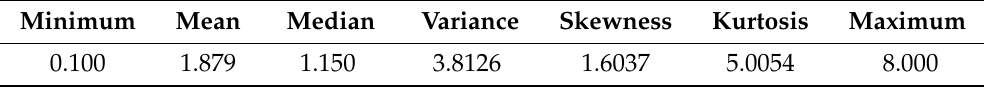
Table 5. Descriptive statistics of the vinyl chloride data set. Minimum